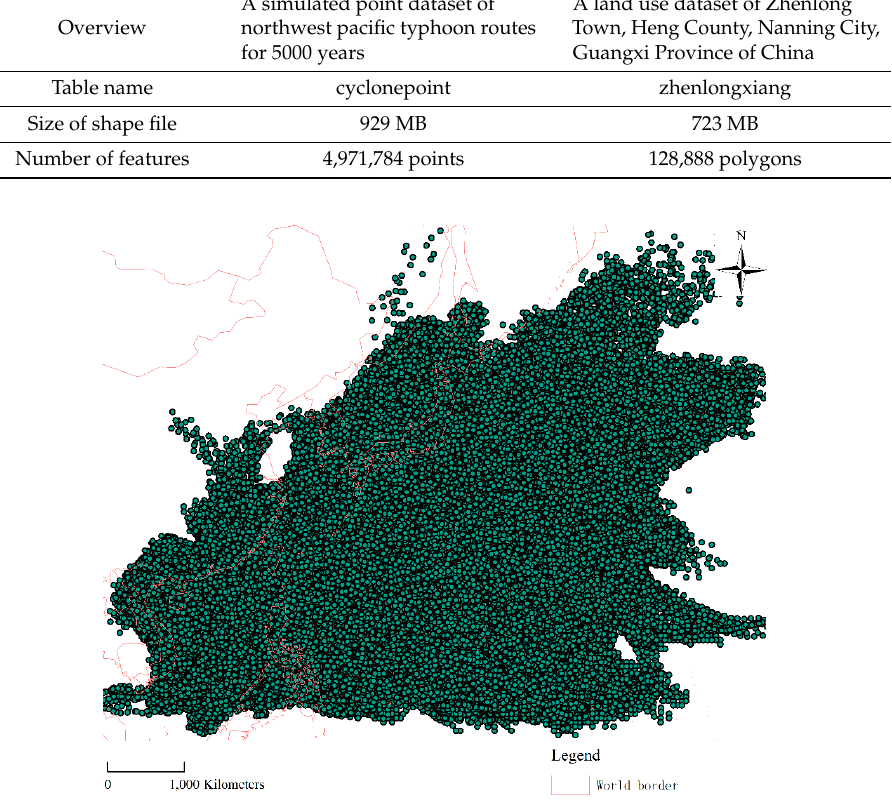
Table 3. Descriptions of test datasets.